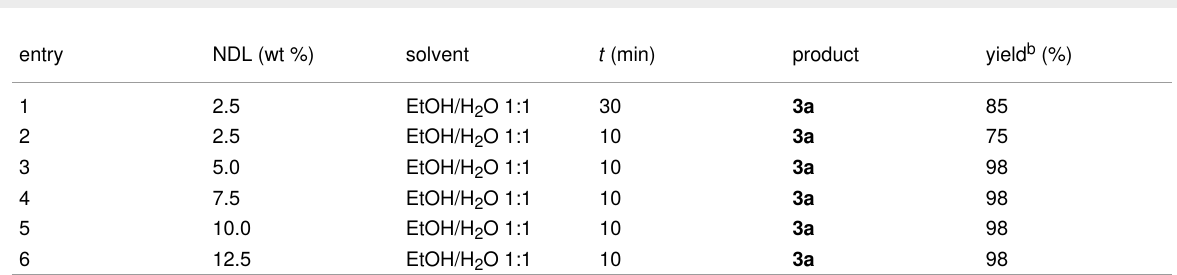
Table 3: Effect of the catalyst loading. a